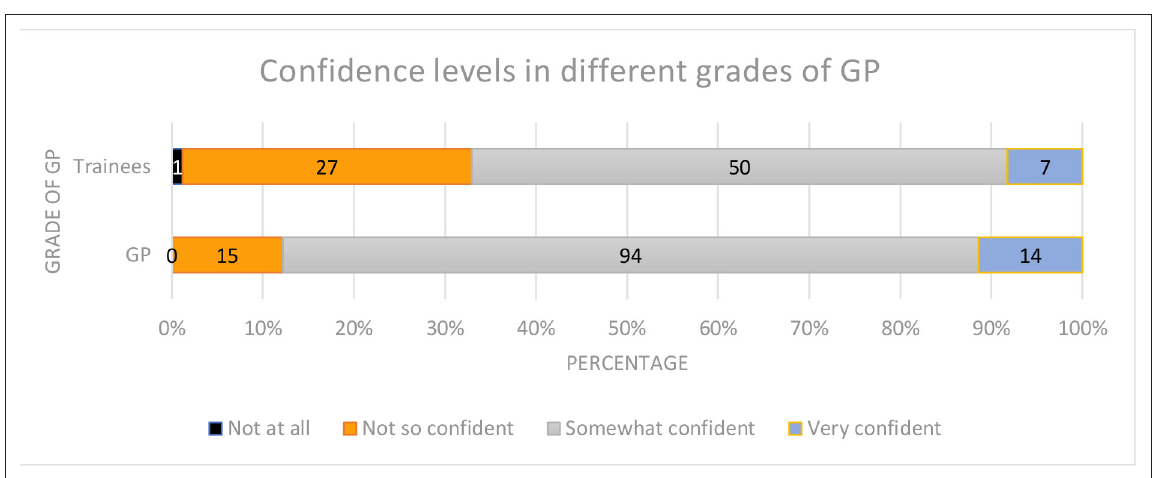
Figure 3 Participants confidence levels with regards to managing women with